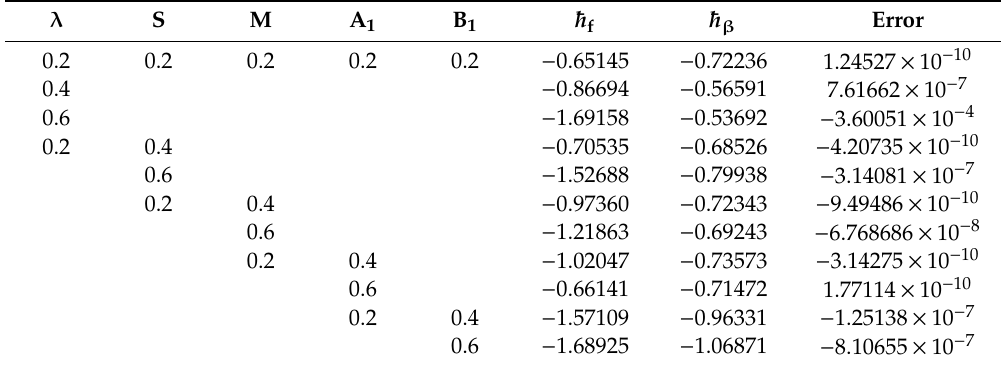
Table 4. The values of auxiliary parameters.